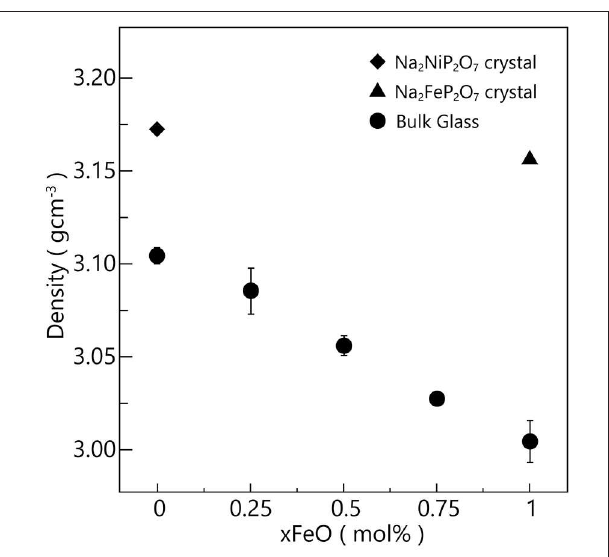
FIGURE 2 | XRD patterns of the fabricated Na 2 Fe x Ni 1 − x P 2 O 7 , (A) bulk; (B) powder.